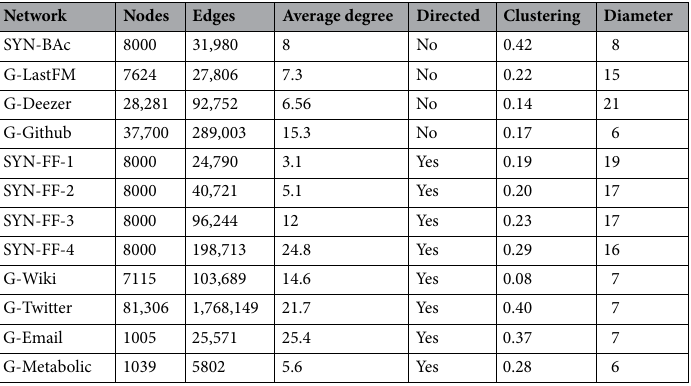
Table 2. Properties of network